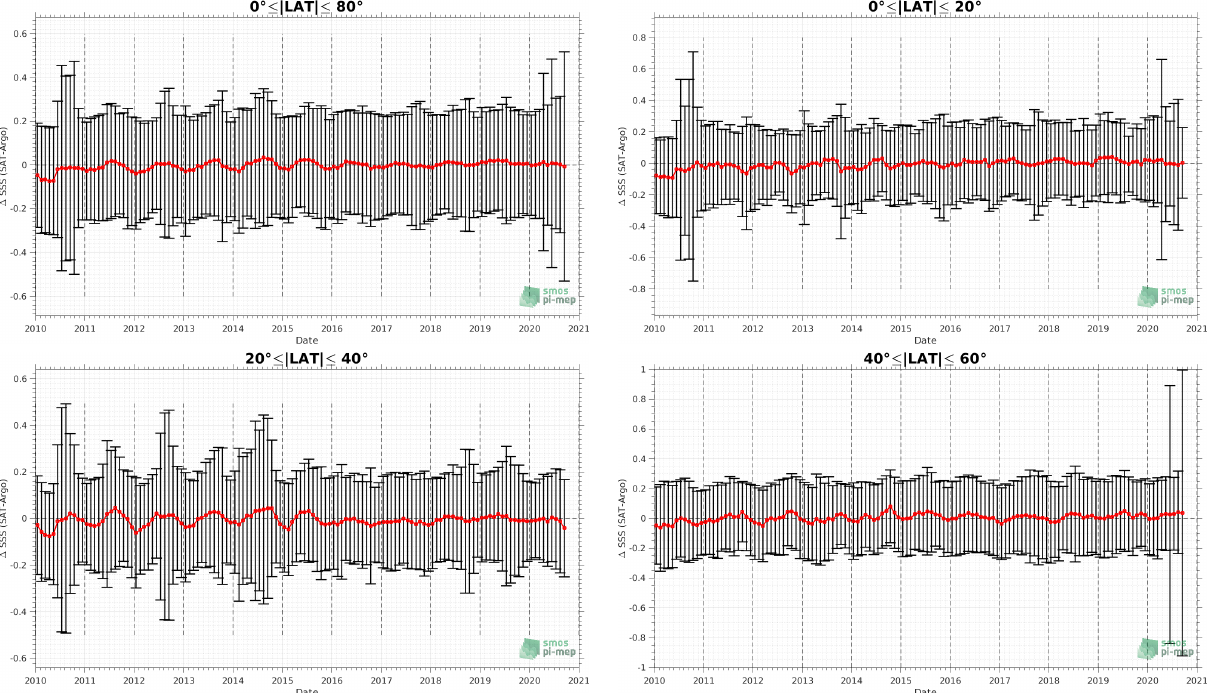
Figure 12. Monthly median (red curves) of ∆ SSS (Satellite−Argo) and ± 1 STD (black vertical thick bars) as function of time for all the collected Pi-MEP match-up pairs estimated over the Global Pi-MEP region and for the full satellite product period are shown for different latitude bands: (a) 80 ◦ S–80 ◦ N, (b) 20 ◦ S–20 ◦ N, (c) 40 ◦ S–20 ◦ S and 20 ◦ N–40 ◦ N and (d) 60 ◦ S–40 ◦ S and 40 ◦ N–60 ◦